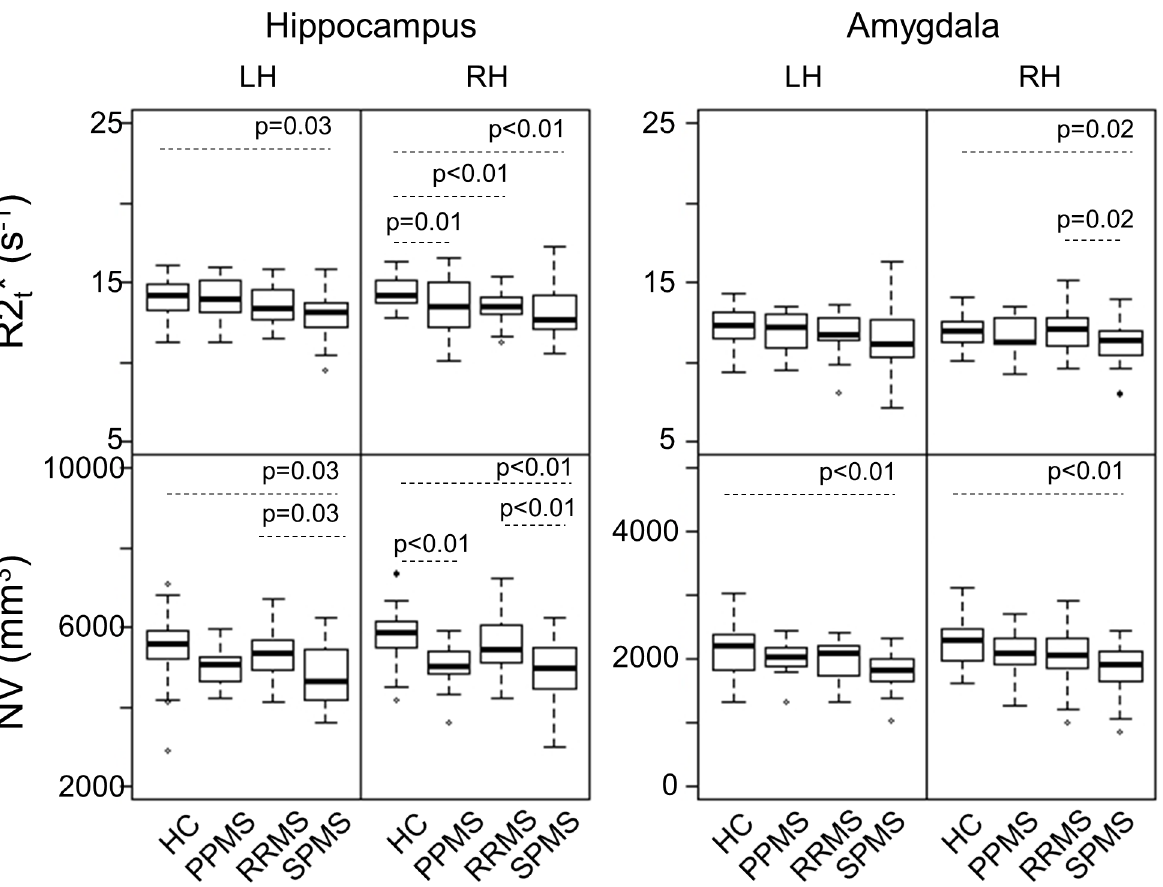
Fig 4. HC versus different MS sub-groups comparisons of R2t * (top) and NV (bottom) of hippocampus and amygdala for each hemisphere. Significant p-values(with FDR correction) are listed in each panel. LH = Left Hemisphere; RH = Right Hemisphere.